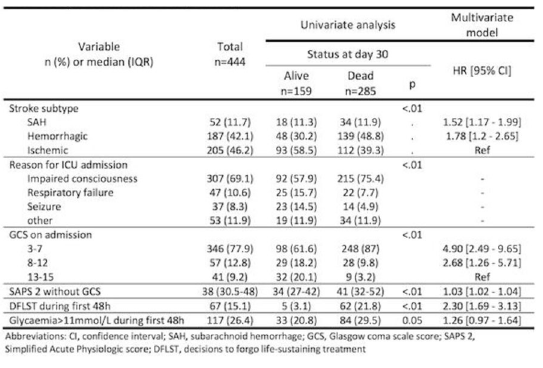
Table 1 (abstract 0363). Prognostic factors of 30-day mortality